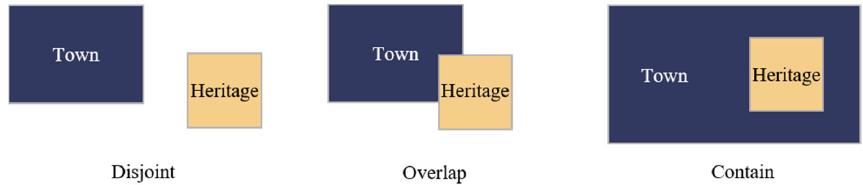
Figure 2. Eight spatial relations in GIS topology theory. Figure 3. Simplified spatial relationships between cultural heritage sites and towns.